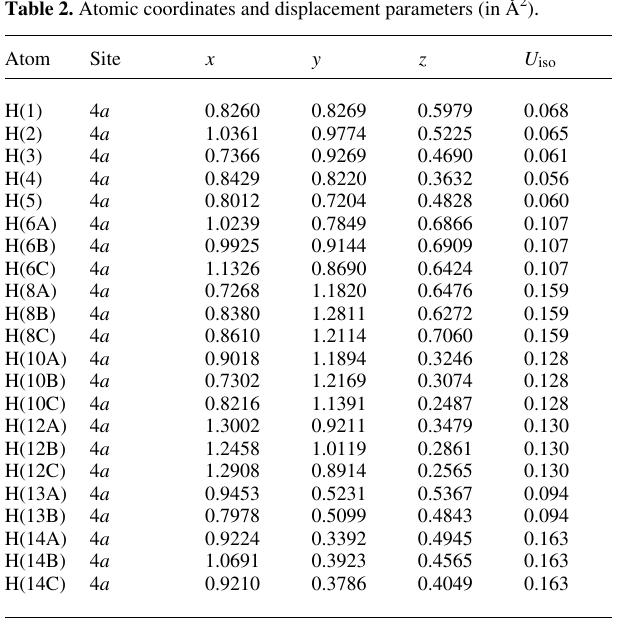
Table 2. Atomic coordinates and displacement parameters (in Å 2 )